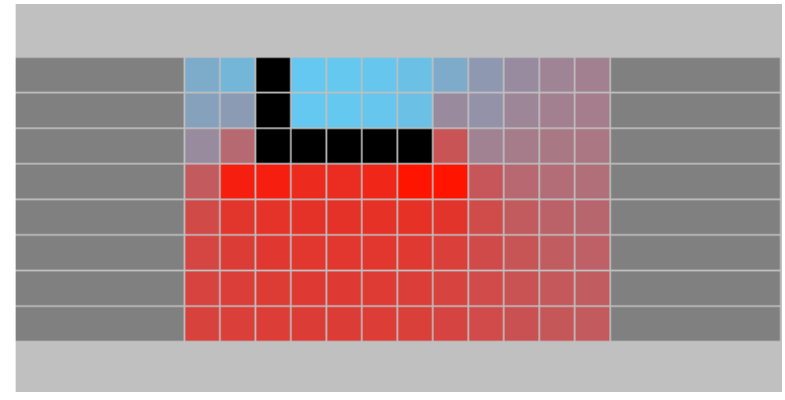
Figure 5. General view of the simulated resistor with a gradient fill.